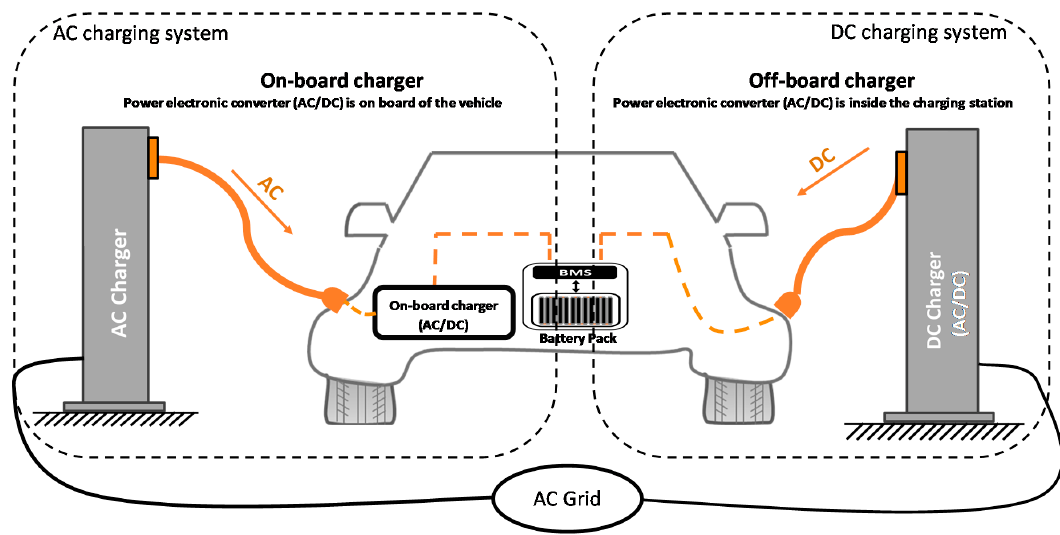
Figure 4. On-board charger versus off-board charger.